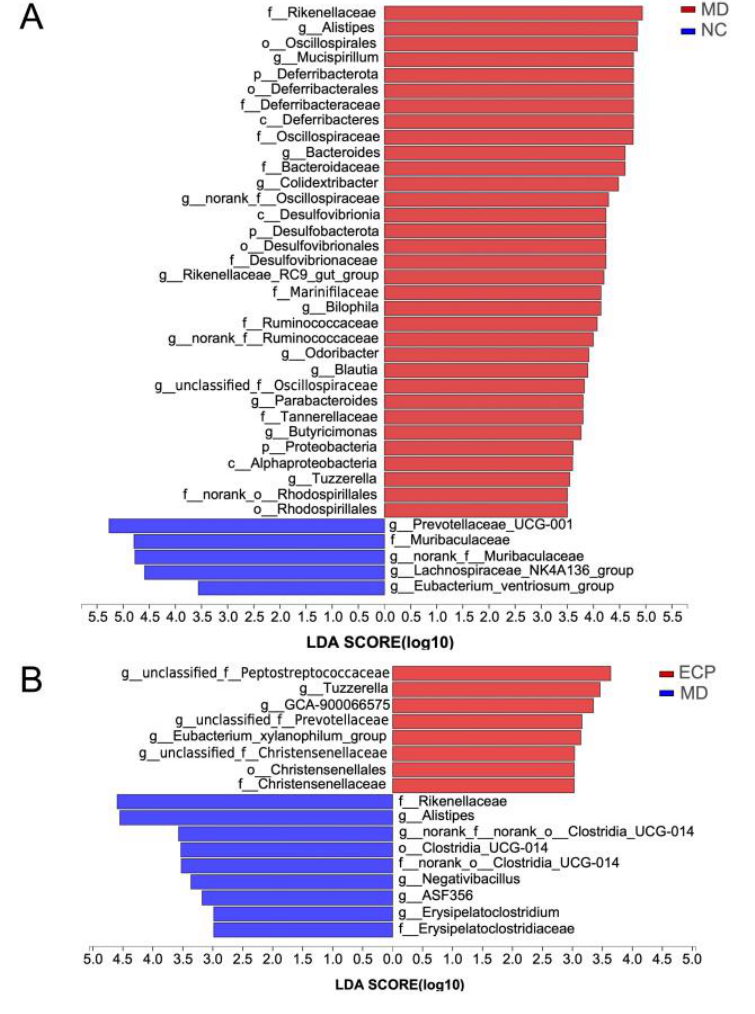
Figure 5. LEfSe analysis of the gut microbiota between NC and MD ( A ) and MD and ECP ( B ) groups. Given that ECP significantly changed the structure of the gut microbiota, we further explored the effect of ECP on the metabolic functions of the gut microbiome (Figure S6A). Clusters of orthologous genes (COG) function analysis indicated that HFD remarkably modified the metabolic capabilities of the gut microbiota including carbohydrate transport and metabolism, energy production and conversion, amino acid transport and metabolism, lipid transport and metabolism and secondary metabolites biosynthesis, transport,